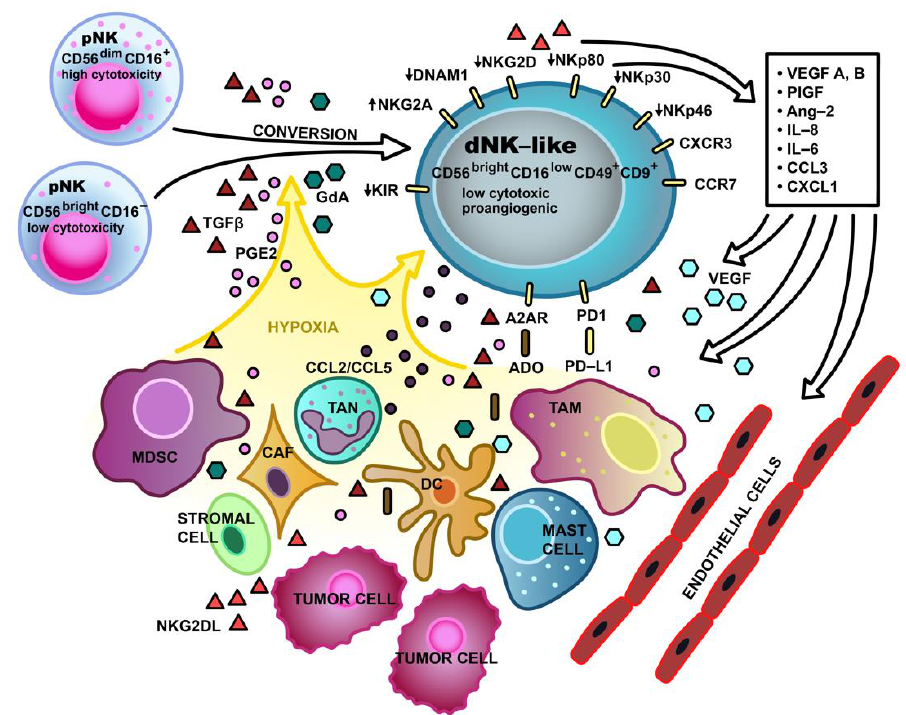
Figure 2. Proangiogenic phenotype of tumor-infiltrating natural killer (TINK) cells induced and maintained by the tumor microenvironment (TME). The TME induces phenotype conversion of highly cytotoxic CD56 low CD16 bright and weakly cytotoxic CD56 bright CD16 − natural killer (NK) cells derived from peripheral blood (pNK) to CD56 bright CD16 low CD49 + CD9 + decidual-like NK (dNK-like) cells. Cellular components of TME, namely tumor-associated macrophages (TAM), cancer-associated fibroblasts (CAF), tumor-associated neutrophils (TAN), myeloid-derived suppressor cells (MDSC), DC, mast cells, cancer cells, and stromal cells, produce proangiogenic, and tolerogenic factors which affect TINK cells. The main factors participating in the pNK-cell phenotype switch are TGF- β , glycodelin-A (GdA), prostaglandin E2 (PGE2), and hypoxia. Moreover, these factors together with adenosine (ADO), PD-L1, and NKG2DL maintain the dNK-like phenotype of TINK cells. This weakly cytotoxic and proangiogenic phenotype is manifested by an increased NKG2A expression; decreased KIR, NKG2D, NKp30, NKp46, NKp80, and DNAM1 expression; presence of CXCR3 and CXCR7; and upregulated production of VEGF, PlGF, Ang-2, IL-6, IL-8, CCL3, and CXCL1. In turn, proangiogenic factors produced by TINK cells affect certain cellular components of the TME, including endothelial cells, and stimulate neovascularization.